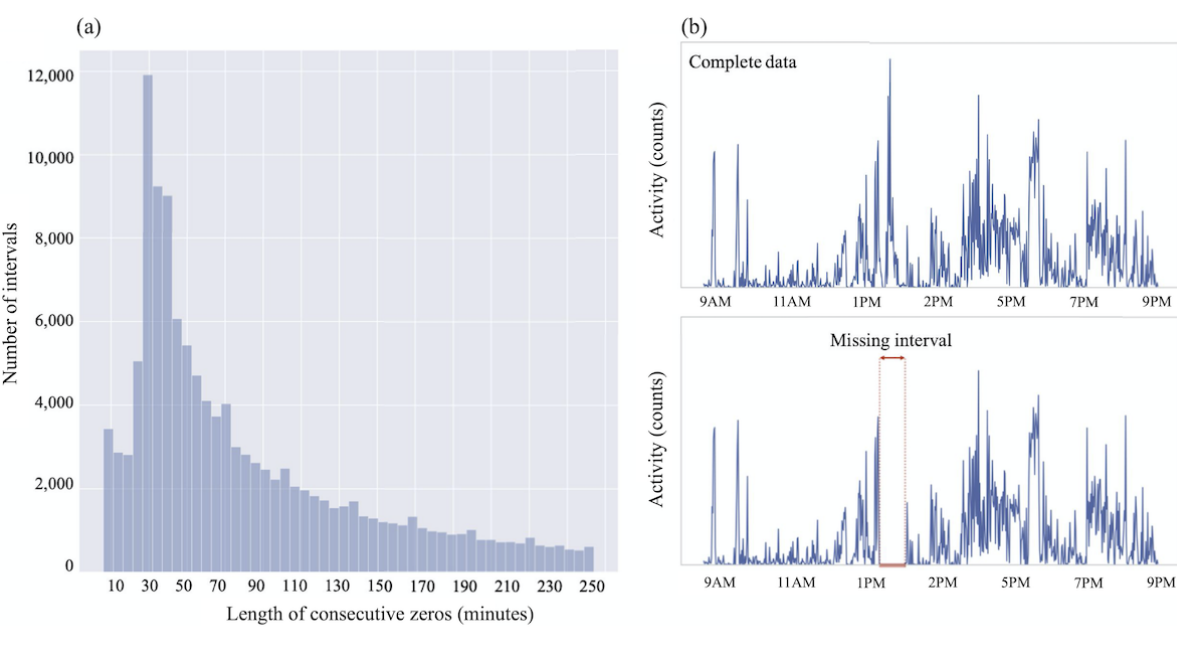
Figure 2. (a) Frequency of missing data intervals found in the NHANES data set. The interval of approximately 30 minutes occurred most frequently. (b) Example of a complete data record and of a record with missing data